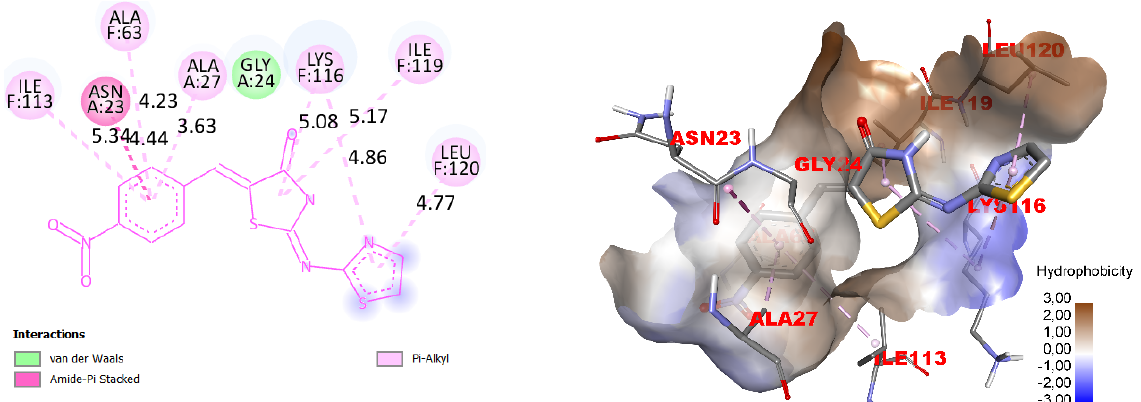
Figure 3. 2D and 3D binding mode of Les-6222 with FLAP.